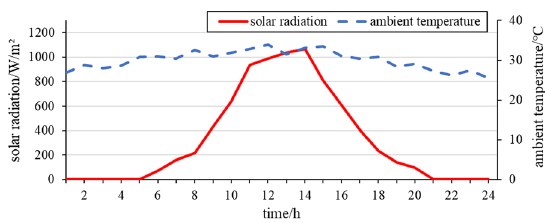
Fig. 8 Typical average daily solar radiation and ambient temperature in summer